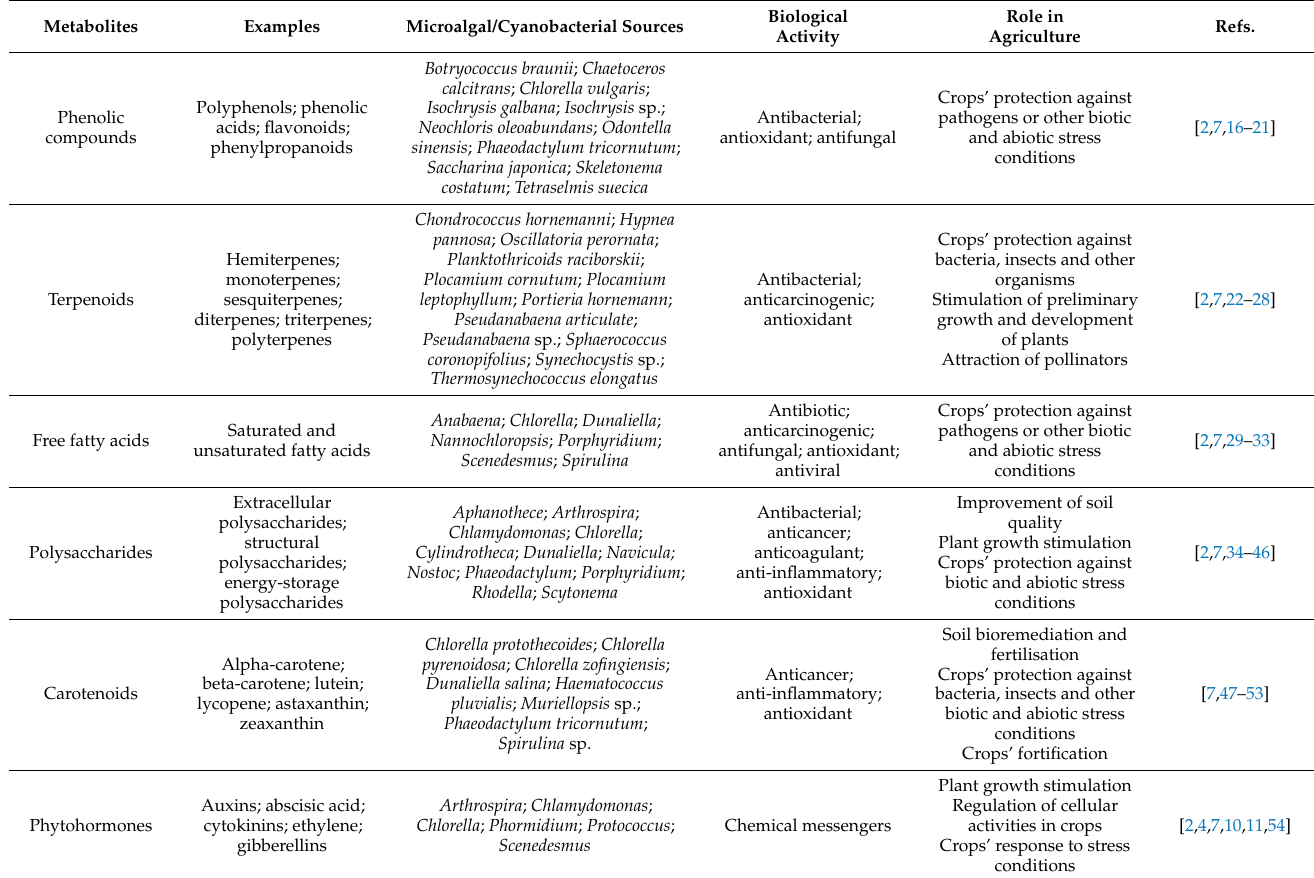
Table 1. Microalgal and cyanobacterial metabolites with potential interest for